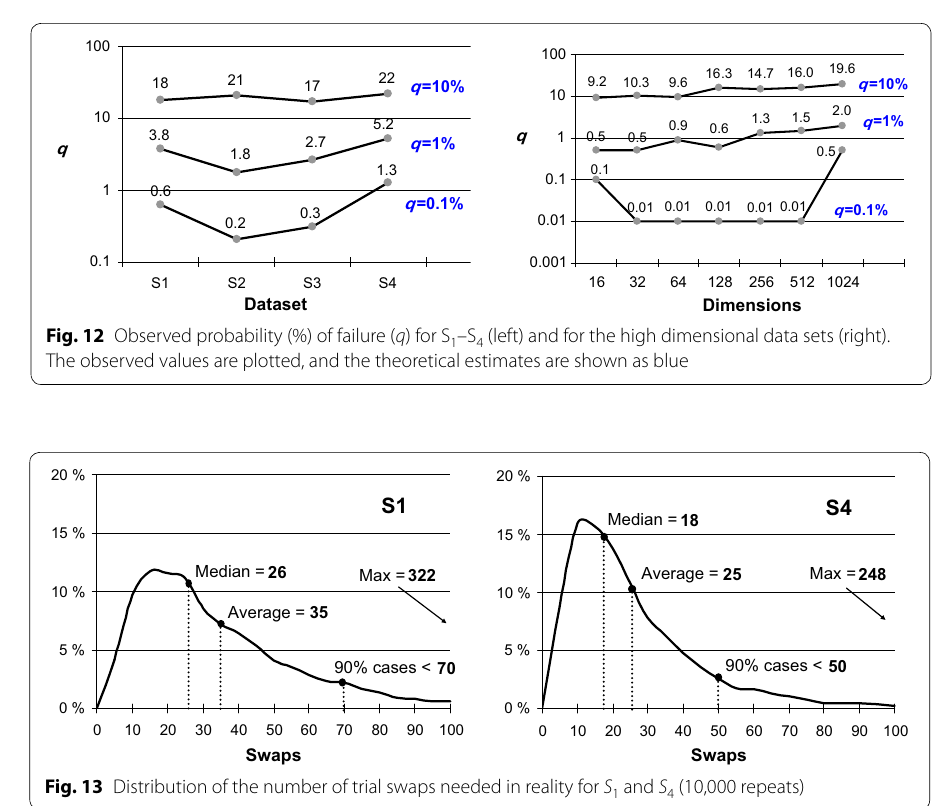
The observed results are recorded using both two (Real 2 ) and ten (Real 10 ) k-means iterations. The number of swaps is calculated from the initial solution. Results are averages of 100 runs